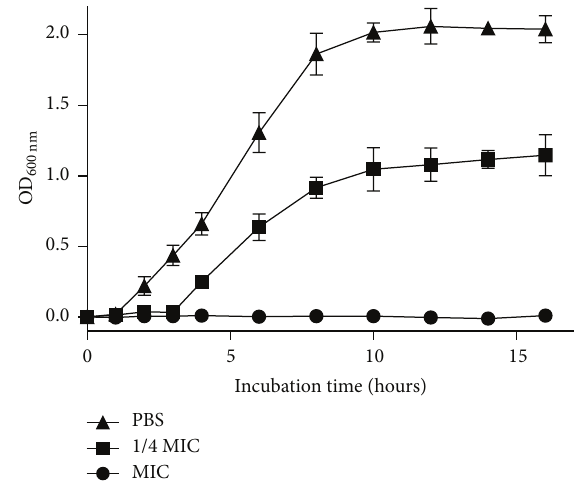
Figure 1: Growth inhibitory activity of Mdc against A. baumannii GIM1.650. The experiment was carried out in triplicate, and plots represent the average values. Error bars refer to the standard deviations.